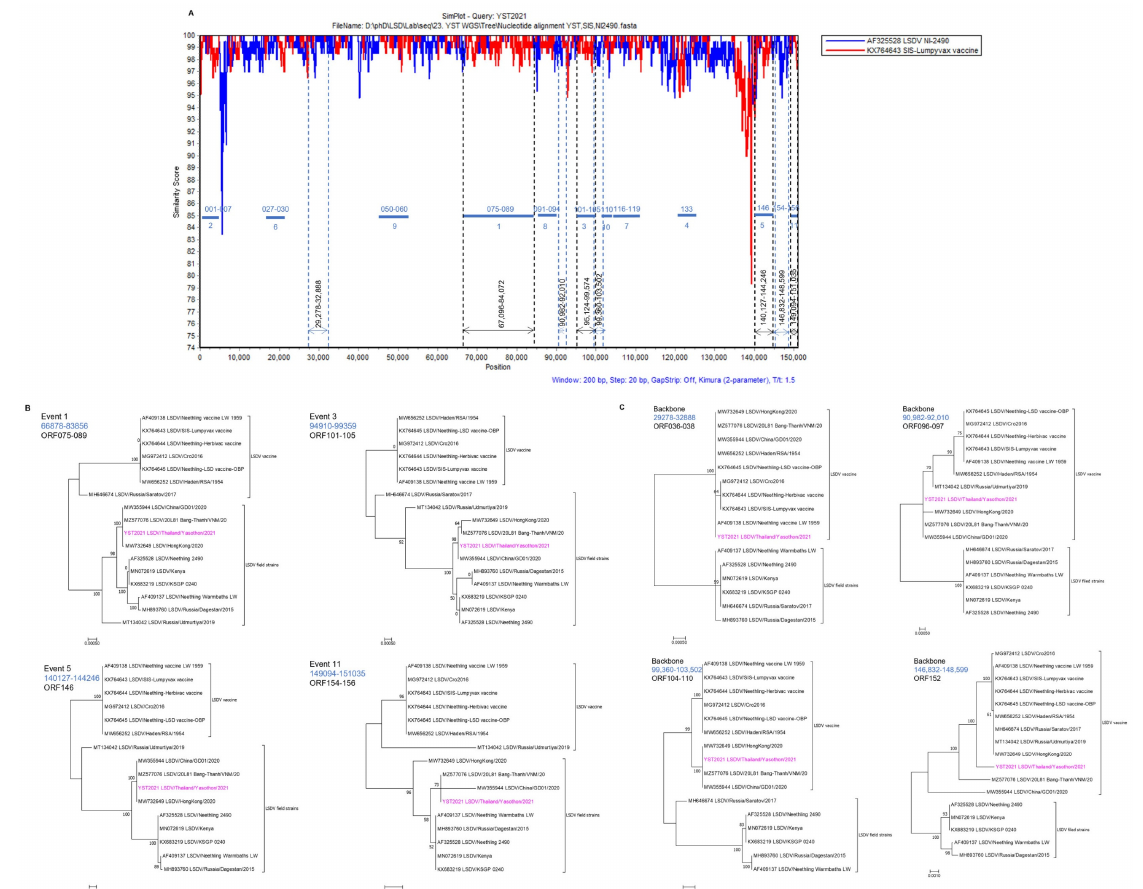
Figure 6. Recombination analysis of the LSDV genome using SimPlot. ( A ) Sequence similarity of the LSDV/Yasothon/2021 was compared to those of the SIS-Lumpyvax vaccine strain (in red) and the field strain NI-2490 (in bright blue). The thick dark-blue horizontal lines represent the positions of the predicted recombination events. The numbers on the horizontal lines are the ORF numbers. The numbers under the horizontal lines are the order of the recombination events . Eight regions selected for the phylogenetic analyses were marked by arrows with the nucleotide sequence positions . ( B , C ) Phylogenetic trees for the donor regions of 4 recombination events and 4 selected backbone sequences, respectively. Blue numbers indicate the sequence positions used for the phylogenetic analyses, and the LSDV / Yasothon / 2021 genome is pink . The phylogenetic tree construction and evolutionary analyses were performed as described in the method. Recombination identification and analysis were conducted in RDP software package version 4 . 101 .